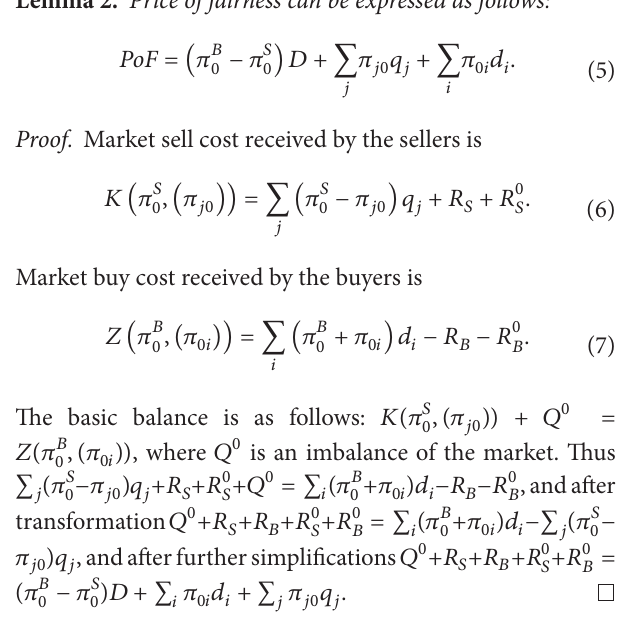
𝜋 𝑑 ∑ 0𝑖 𝑗 ; thus 𝑗 𝐾(𝜋 𝑆 ) 0 ) and 𝑍(𝜋 𝐵 ) is constant 0 0